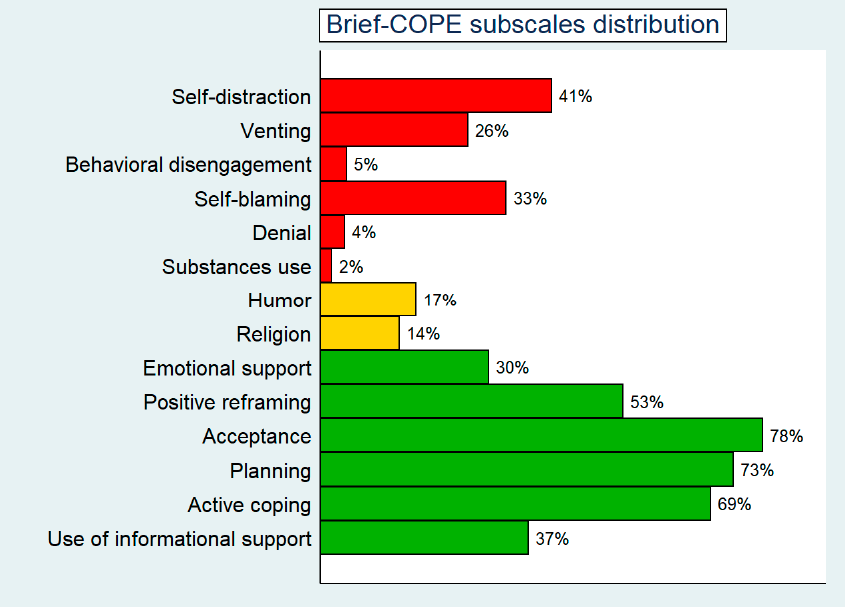
Figure 1. Brief-COPE subscales distribution in the whole sample. Avoidant coping subscales are colored in red, active coping subscales in green, and neither active nor avoidant coping subscales in yellow, respectively. The frequencies for each coping strategy are reported on the right side of each bar as percentages.